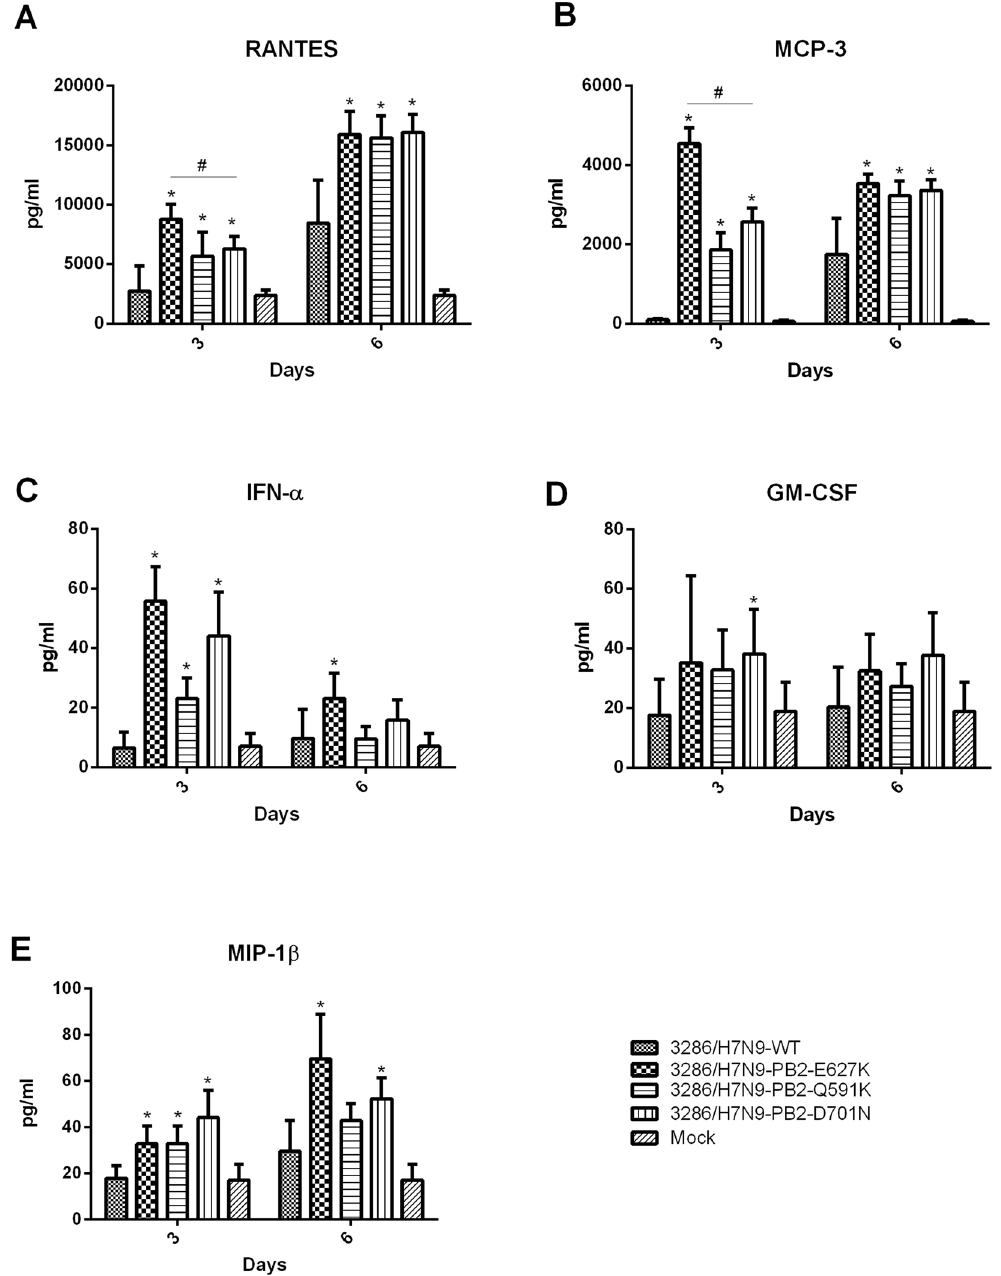
Figure 7. (cont) Cytokine responses in the lungs of mice infected with duck 3286/H7N9 and its PB2 mutants. Cytokine levels ( A ) RANTES ( B ) MCP-3 ( C ) IFN- α ( D ) GM-CSF E) MIP-1 β from virus infected lungs (n = 6 mice per virus group, days 3, 6 post-inoculation) were measured individually by the FlowCytomi x system. Results from each time point are expressed as mean ± SD of six infected mice from two independent experiments. * The values were statistically compared with the wild type 3286/H7N9 using the two tailed, non- paired t-test. p <